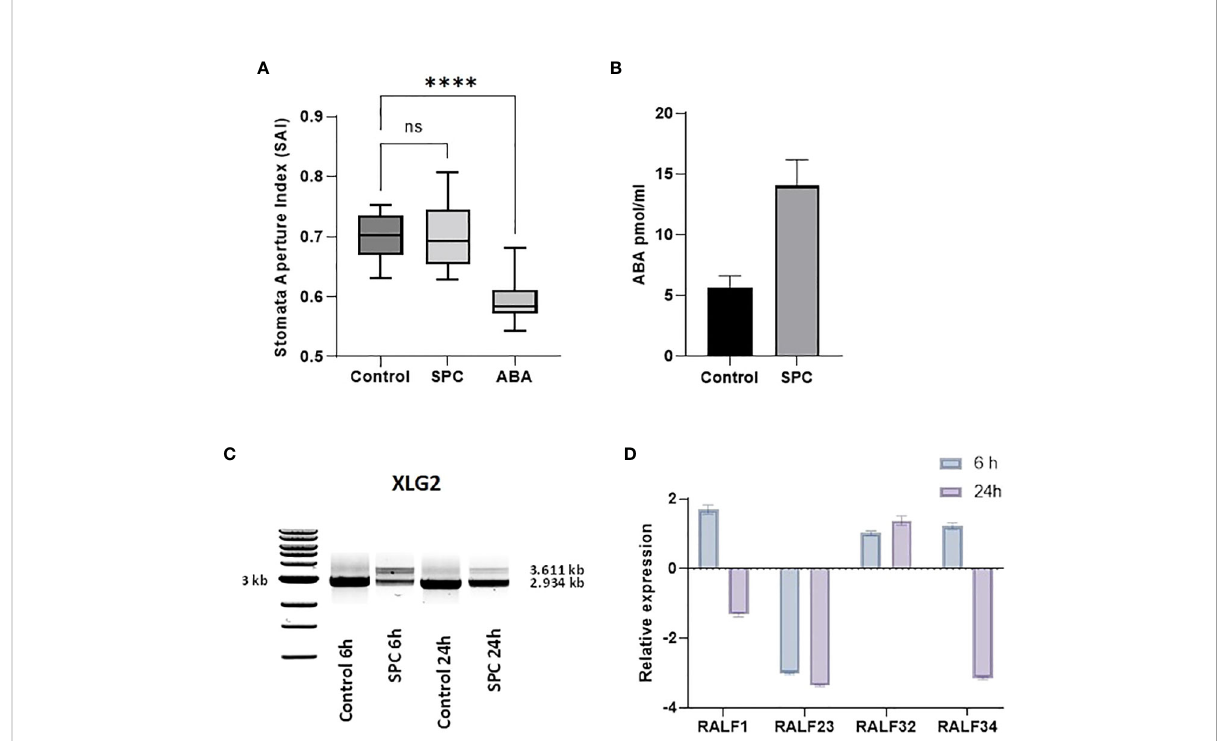
FIGURE 6 Impact of SPC on stomata aperture and the involvement of ABA signaling. Stomata aperture of Arabidopsis leaves (n=20) was measured in various conditions (see Materials and Methods). Data were analyzed with one-way ANOVA multiple comparisons to con fi rm the signi fi cant difference between control and SPC-treated samples versus ABA-treated samples; ns, no signi fi cance; symbol **** means statistically signi fi cant difference between treatments (p < 0.0001) (A) . ABA concentrations were measured 6 h post treatment of 7 day old Arabidopsis seedlings SPC- treated and control tissues. Data are shown as mean ± SD, (n=3) (B) . Effect of spliceostatin C on the expression of XLG2. Samples were collected at two-time points (6 and 24 h) after exposure to 2.2 µM of SPC. RNA was extracted and used for RT-sqPCR analysis (C) . Expression of RALF genes in response to SPC. Four RALF genes (RALF1, RALF23, RALF 32 and RALF34) were examined by quantitative reverse transcription- polymerase chain reaction (RT-qPCR) for responsiveness to SPC. Assays were performed in triplicates. Data are shown as mean ± S.D (D)